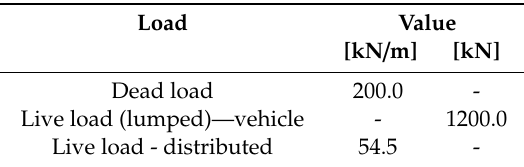
Table 1. Loads and